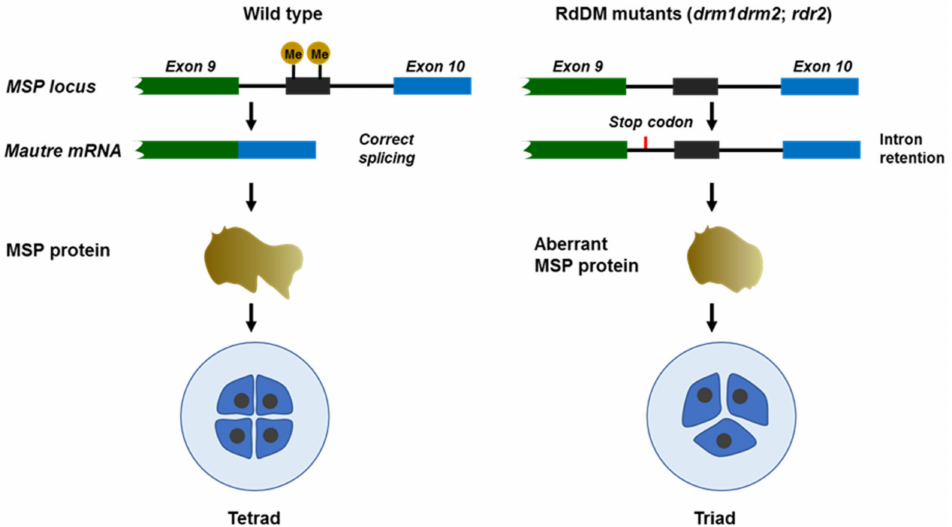
Figure 2. DNA methylation in MSP intron is important for correct splicing and normal